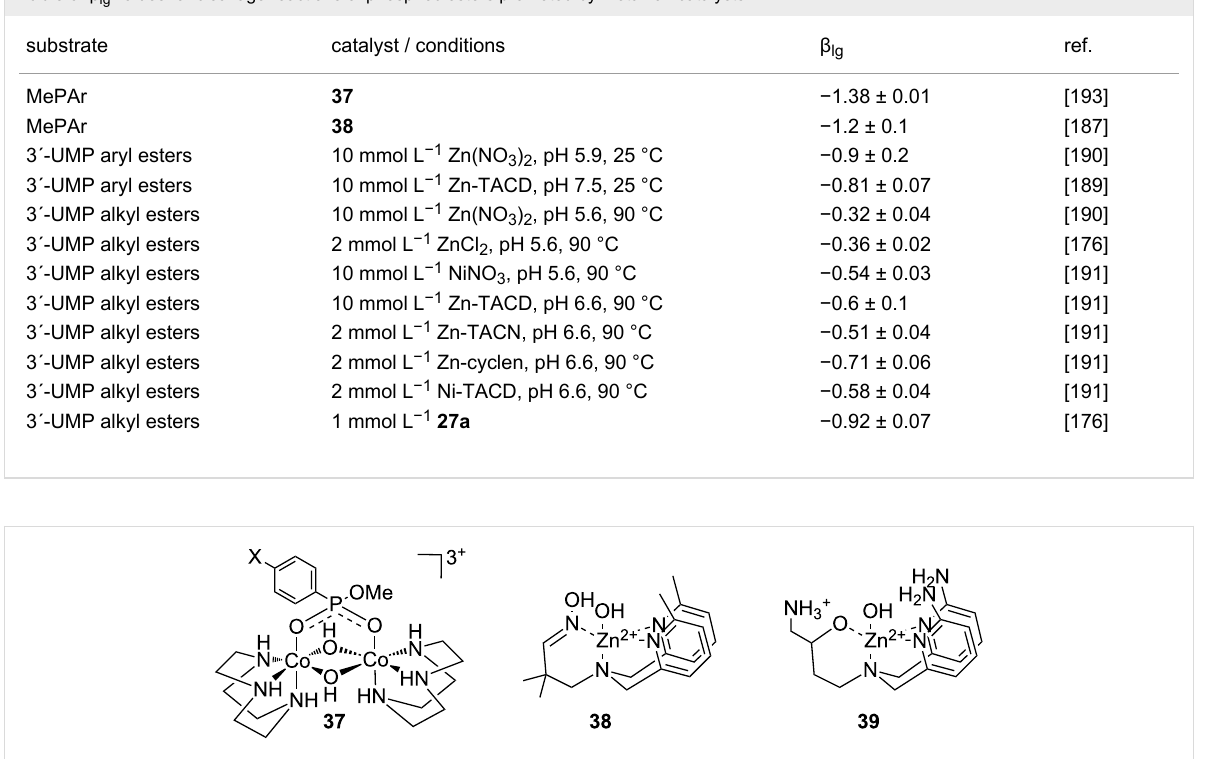
Figure 14: Metal ion complexes used for determination of β lg values of metal-ion-promoted cleavage of RNA model compounds.